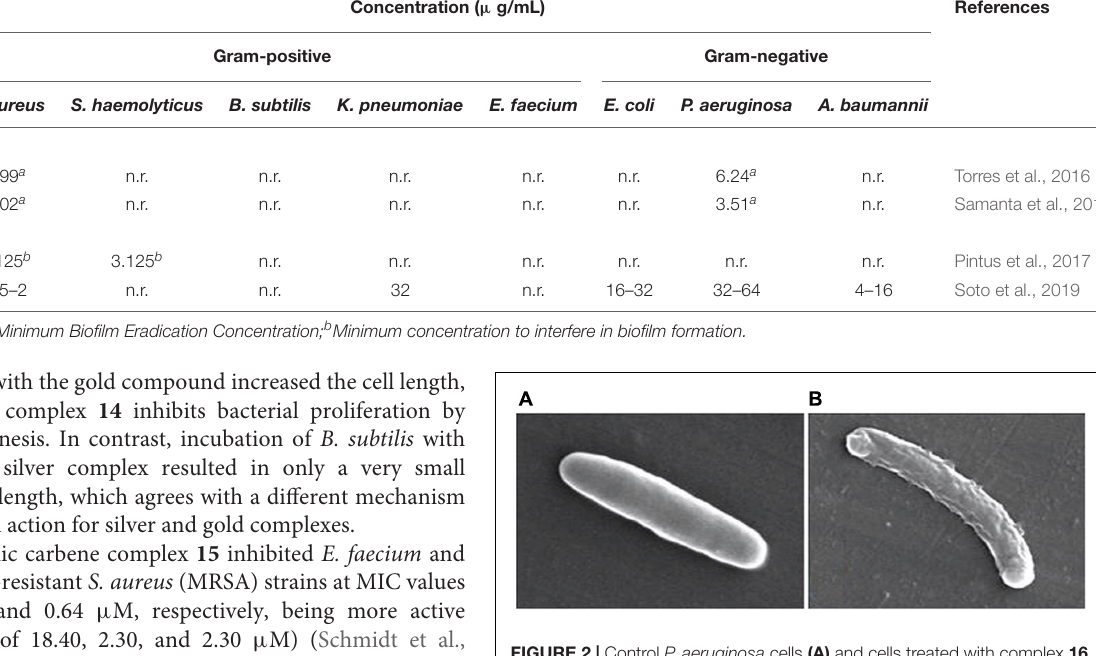
the destabilizing effect on the bacterial membrane is caused by the insertion of multiple molecules of complex 16 intercalating the lipids on the